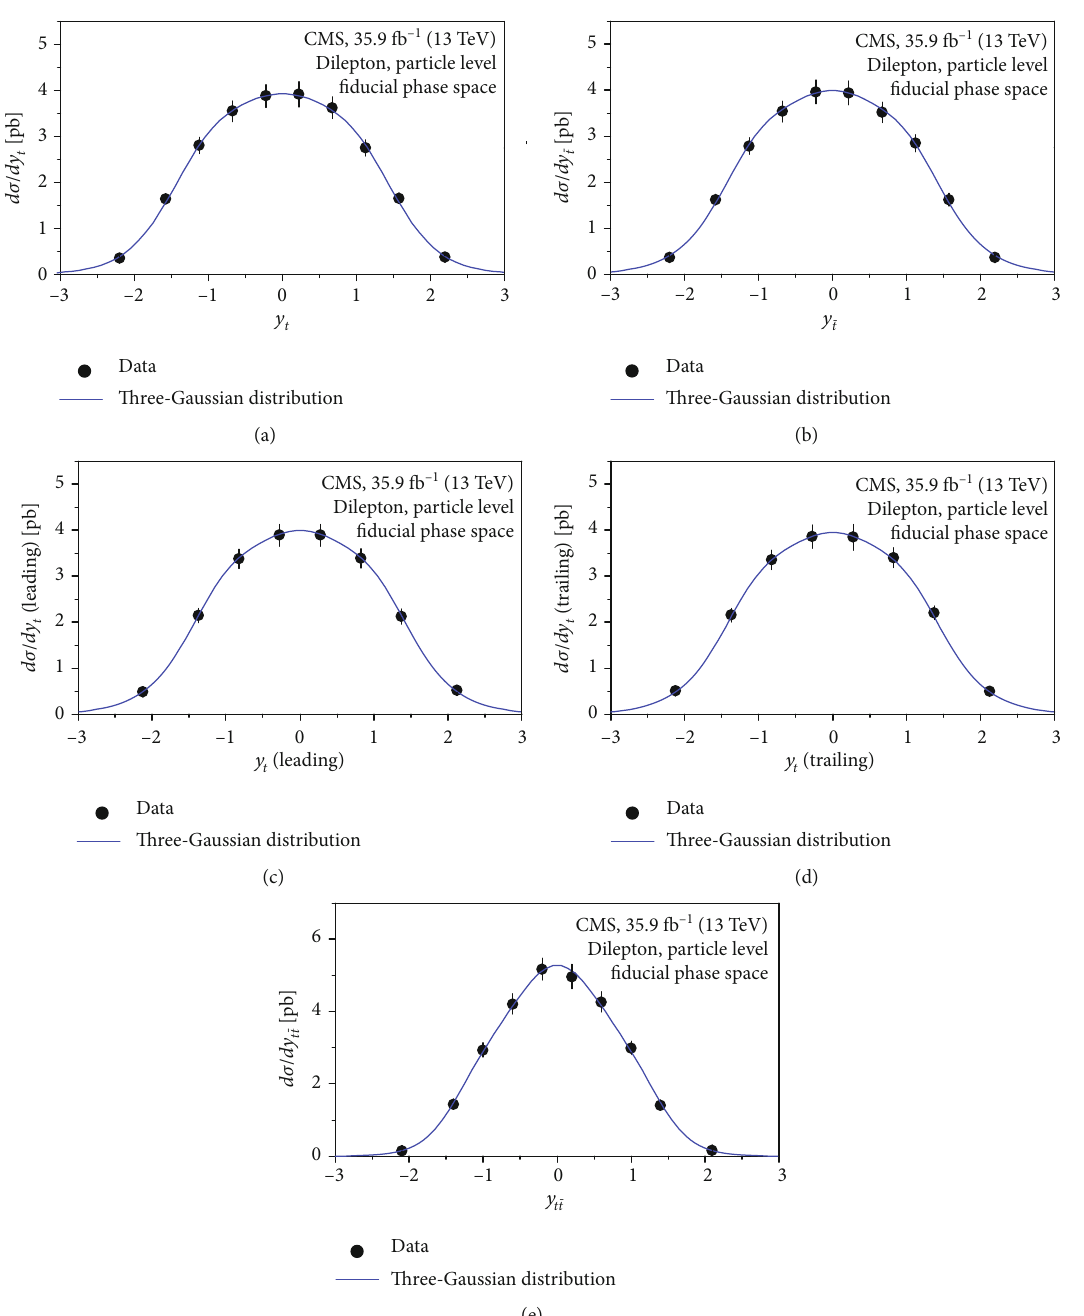
y y (cid:1) t , (c) t , (b) t (leading), (d)